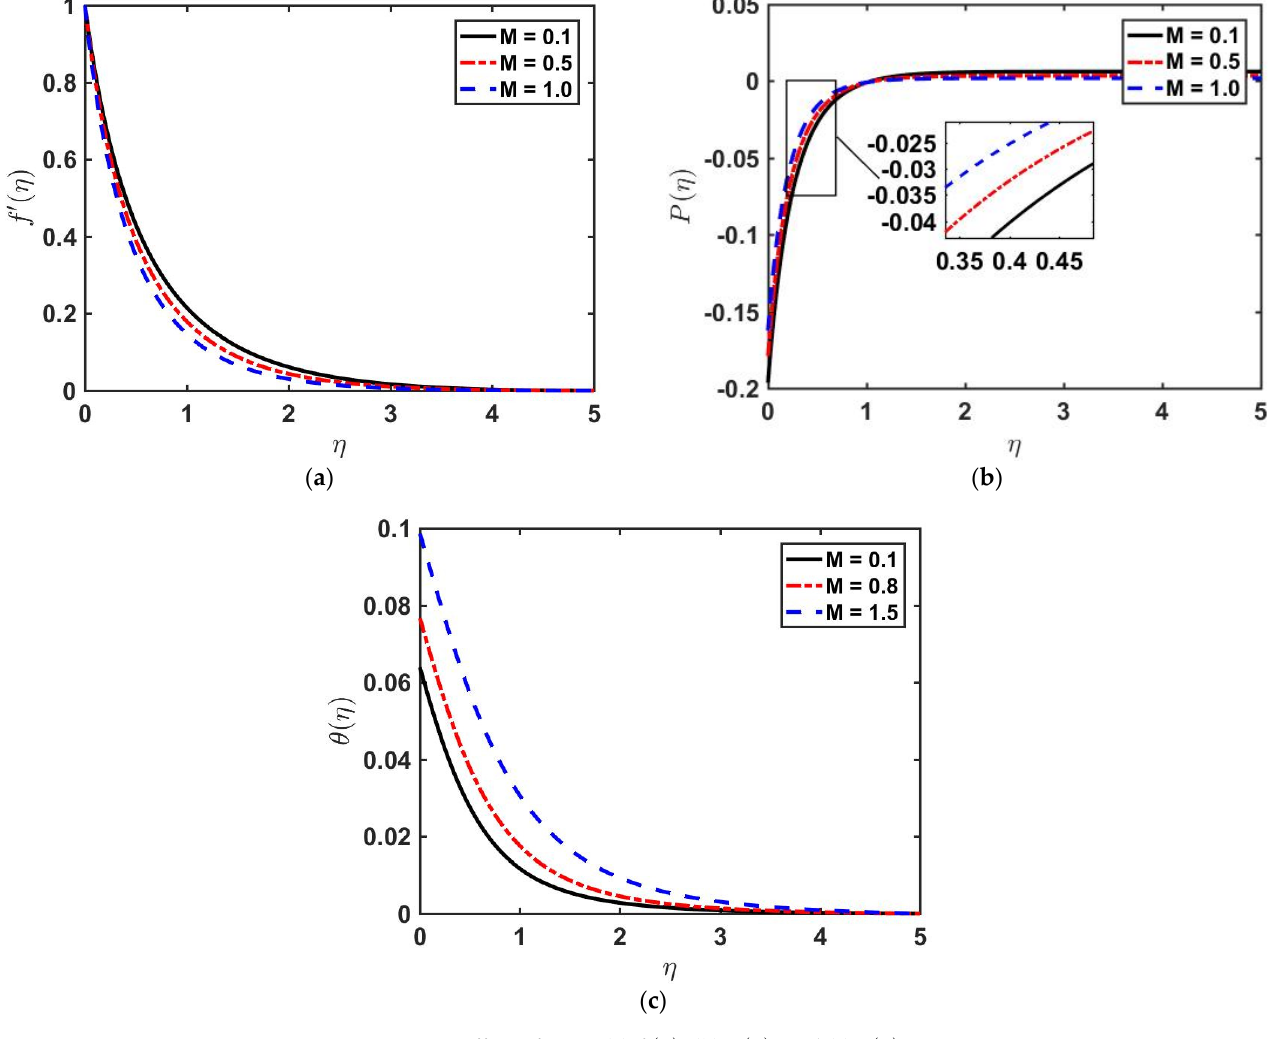
Figure 6. Effect of M on ( a ) f (cid:48) ( η ) , ( b ) P ( η ) , and ( c ) θ ( η ) .